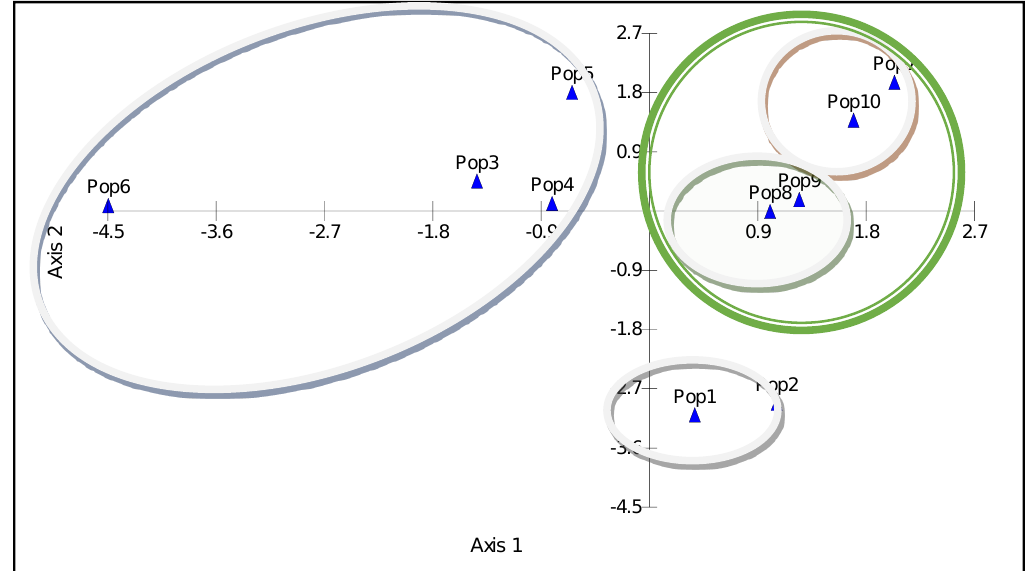
Figure 5. Principal Coordinate Analysis (PCoA) of ten populations of A. javanica based on ISSR molecular markers.